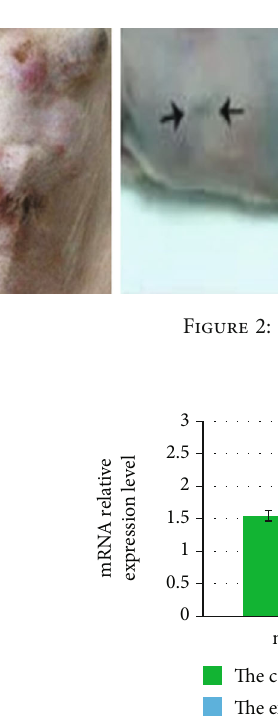
Figure 1: Electron microscopic images of cutaneous MM A375 cells. (a – c) The magni fi cation factors were × 10, × 20, and × 40, respectively.